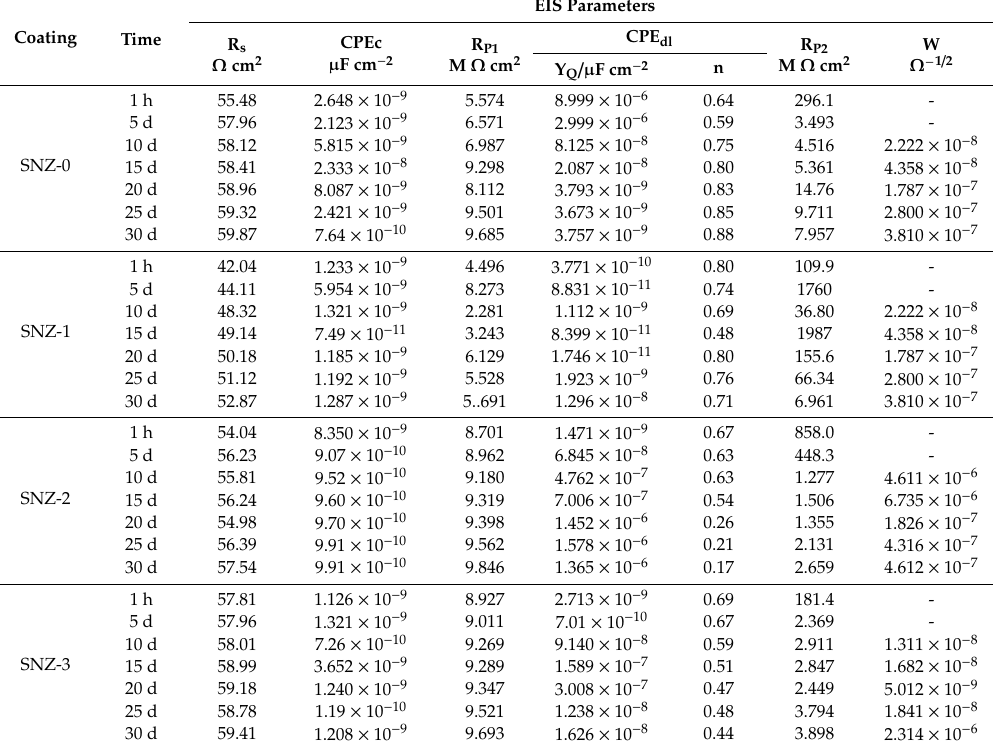
Table 3. Electrochemical impedance spectroscopy (EIS) data of the SNZ samples after di ff erent immersion times in the chloride test